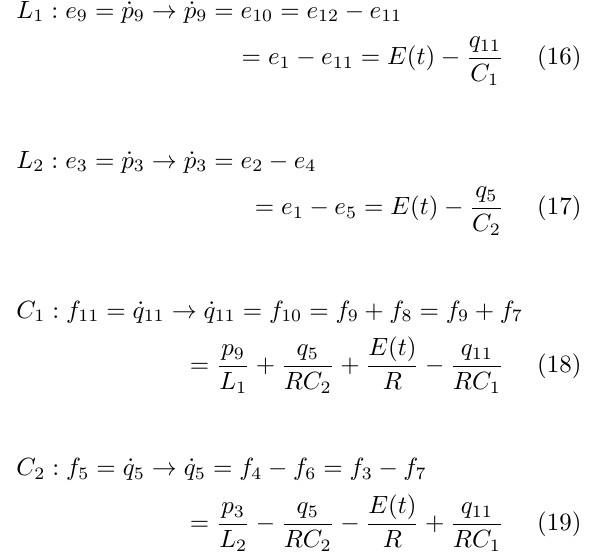
Figure 5: Bond Graph model of the forth order elec- trical circuit presented in Figure 4. (a) First two steps of algorithmic Bond Graph technique (b) Omitting the 0-junction con- nected to the ground and simplifying the Bond Graph (c) Reduced Bond